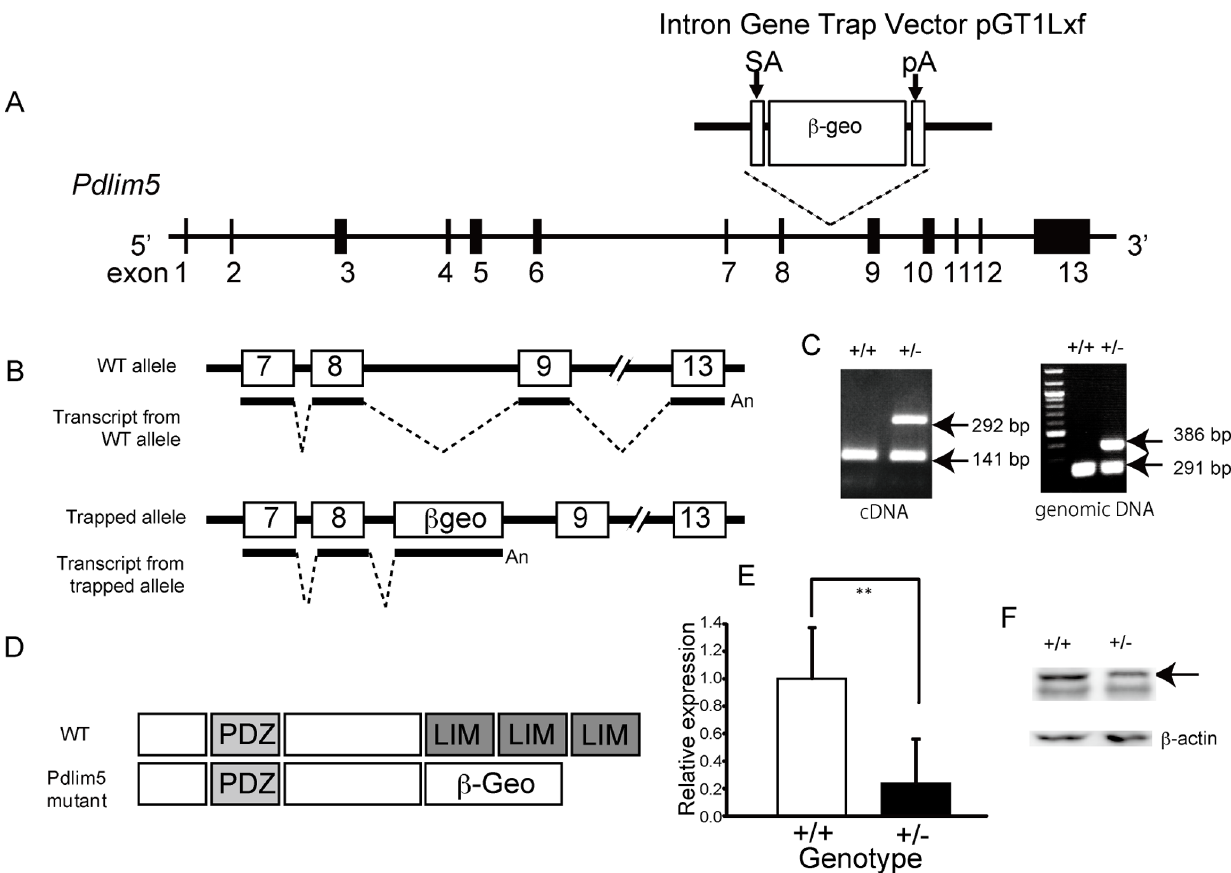
Figure 1. Gene-trap mutagenesis of Pdlim5 . (A) Insertion site of the gene-trap cassette in intron 8 of the Pdlim5 gene. The inserted sequence (gray box) includes a splice acceptor (SA), b -geo, which is a fusion of b -galactosidase and neomycin phosphotransferase II, and is followed by a stop codon and a polyadenylation signal (pA). (B) Schematic of the gene trap cassette. C) RT-PCR results and genomic genotyping of Pdlim5 + / + , Pdlim5 + / 2 . Samples were extracted from the brain and tail. (D) Expected domain structures of wild-type and PDLIM5 mutant proteins. (E) Real-time PCR analysis of Pdlim5 in the prefrontal brains of Pdlim5 + / + (n=6) and Pdlim5 + / 2 (n=8) mice [ F (1, 12)=14.0, p =0.003]. Values are shown as mean 6 SD. (F) Representative western blots of Pdlim5 in the prefrontal brains of Pdlim5 + / + and Pdlim5 + / 2 .